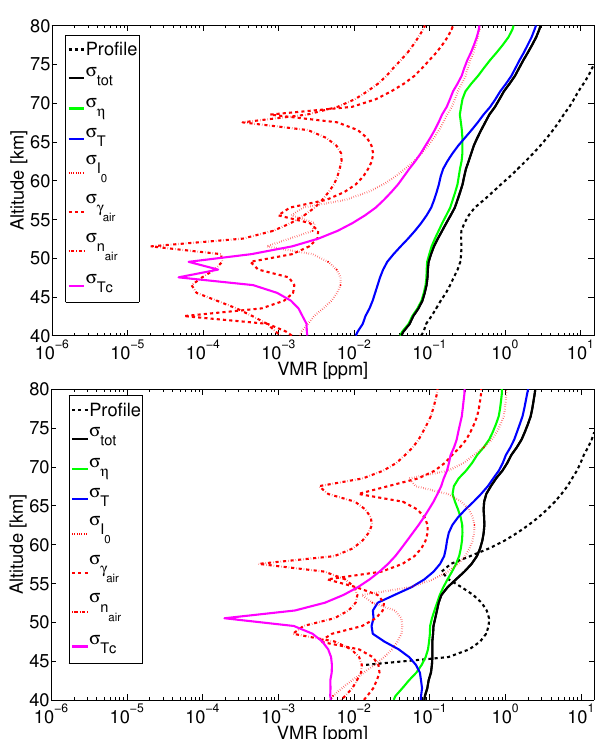
Fig. 7. Typical examples of error contributions. The dominating contributions to the total error σ tot come from the measurement noise error σ η , from the temperature error σ T , and frequently from the spectroscopic error σ I . For comparison, the corresponding vmr 0 profiles are also included (black dashed lines). Top panel: example of 29 October 2009, which has no dominating spectroscopic contri- bution. Bottom panel: example of 4 February 2009, which shows a pronounced spectroscopic contribution at approx.